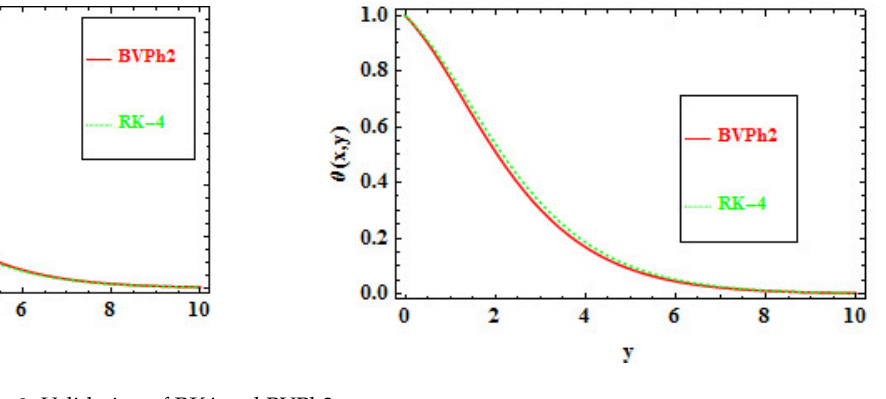
Figure 3. Validation of RK4 and BVPh2.